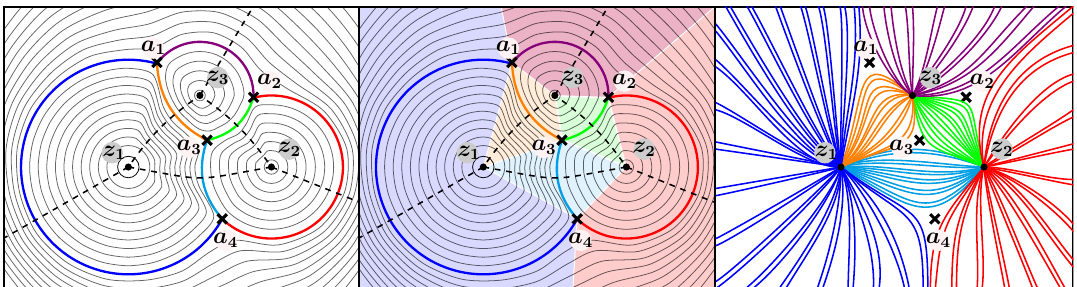
Figure 1 . Open-Closed String Duality and the Strebel Construction. (Left) A foliation of a closed string Riemann Surface Σ g,n by the horizontal trajectories of the associated Strebel differential. The coloured lines are ‘critical’ horizontal trajectories with a k the zeroes of the differential. They form the Strebel graph. The z i are double poles and z 4 = ∞ (not shown). (Middle) The Strebel graph gives a canonical decomposition (‘gluing’) of Σ g,n into (shaded) regions which are conformal to infinite strips. The Strebel lengths are the widths of these strips. (Right) These strips are viewed as open string diagrams (Feynman-’tHooft double lines) which give rise to the free field Wick contractions. The width of the strips is identified with the number of contractions. Note that the skeleton Feynman graph (from gluing together homotopic edges), denoted by the dashed line in the middle and left, is the dual to the Strebel